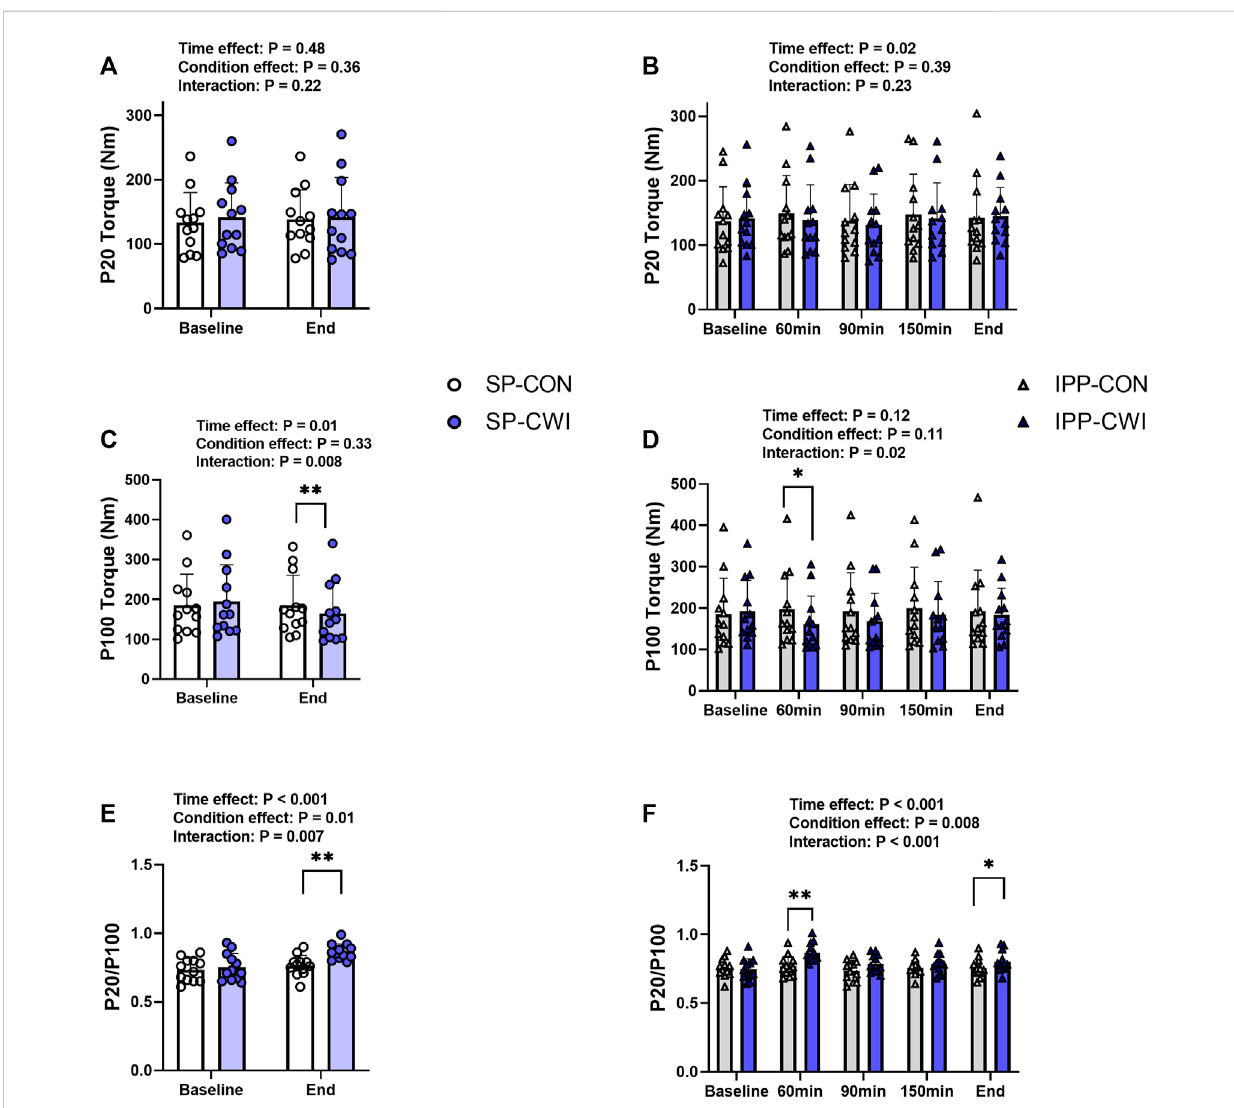
FIGURE 3 Electrically induced isometric torques in the unfatigued state. Peak torques at 20 Hz (P20) (A,B) and 100 Hz (P100) (C,D) , and P20/P100 (E,F) during the single and intermittent/prolonged phases, respectively. Data are shown as mean ± SD and all panels include individual values. SP, single phase; IPP, intermittent/prolonged phase. *, p < 0.05; **, p < 0.01: Signi fi cant differences CON vs. CWI. N =